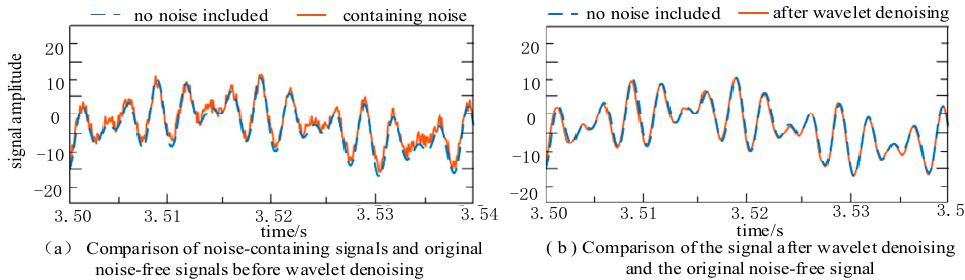
( b ) Comparison of the signal after wavelet denoising and the original noise-free signal Figure 6. Comparison of each signal before and after wavelet denoising.